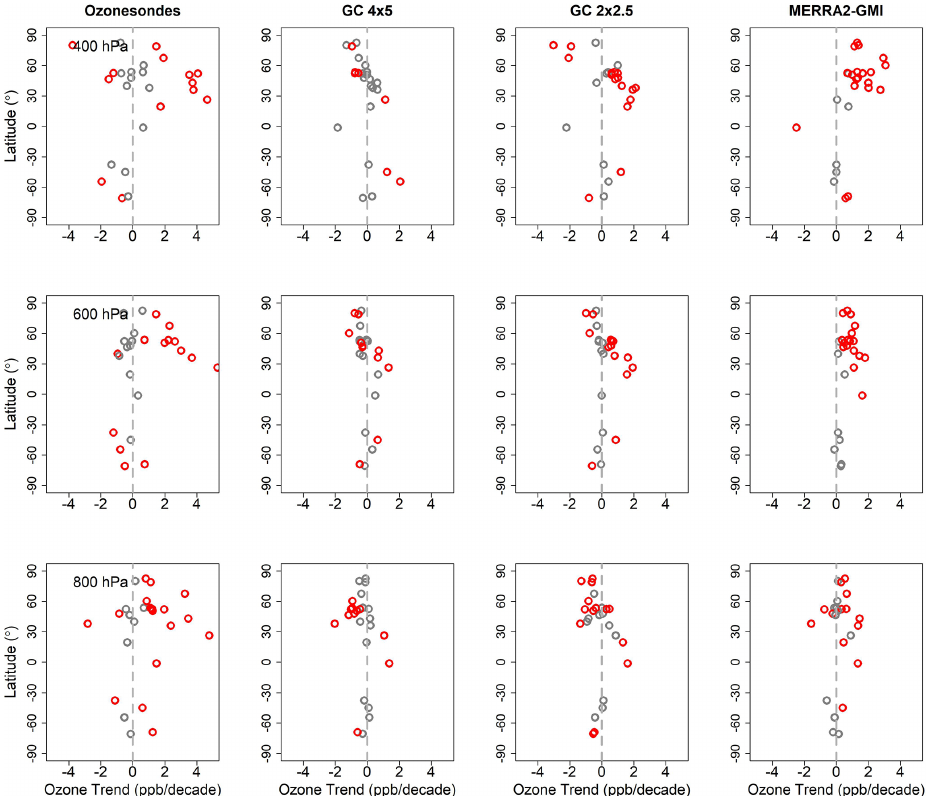
Figure 7. Summary of 1990–2017 trends in ozonesondes (left column) and the simulations (other columns). GC 4 × 5 refers to the GEOS- Chem v12.9.3 simulations at 4 ◦ × 5 ◦ , GC 2 × 2 . 5 is the same model at 2 ◦ × 2 . 5 ◦ , and MERRA2-GMI refers to the NASA GEOS GMI at ∼ 50km resolution. The trend (in ppb per decade) is plotted as a function of ozonesonde launch site latitude. Red circles indicate significant trends ( p < 0 . 1), and gray circles indicate insignificant